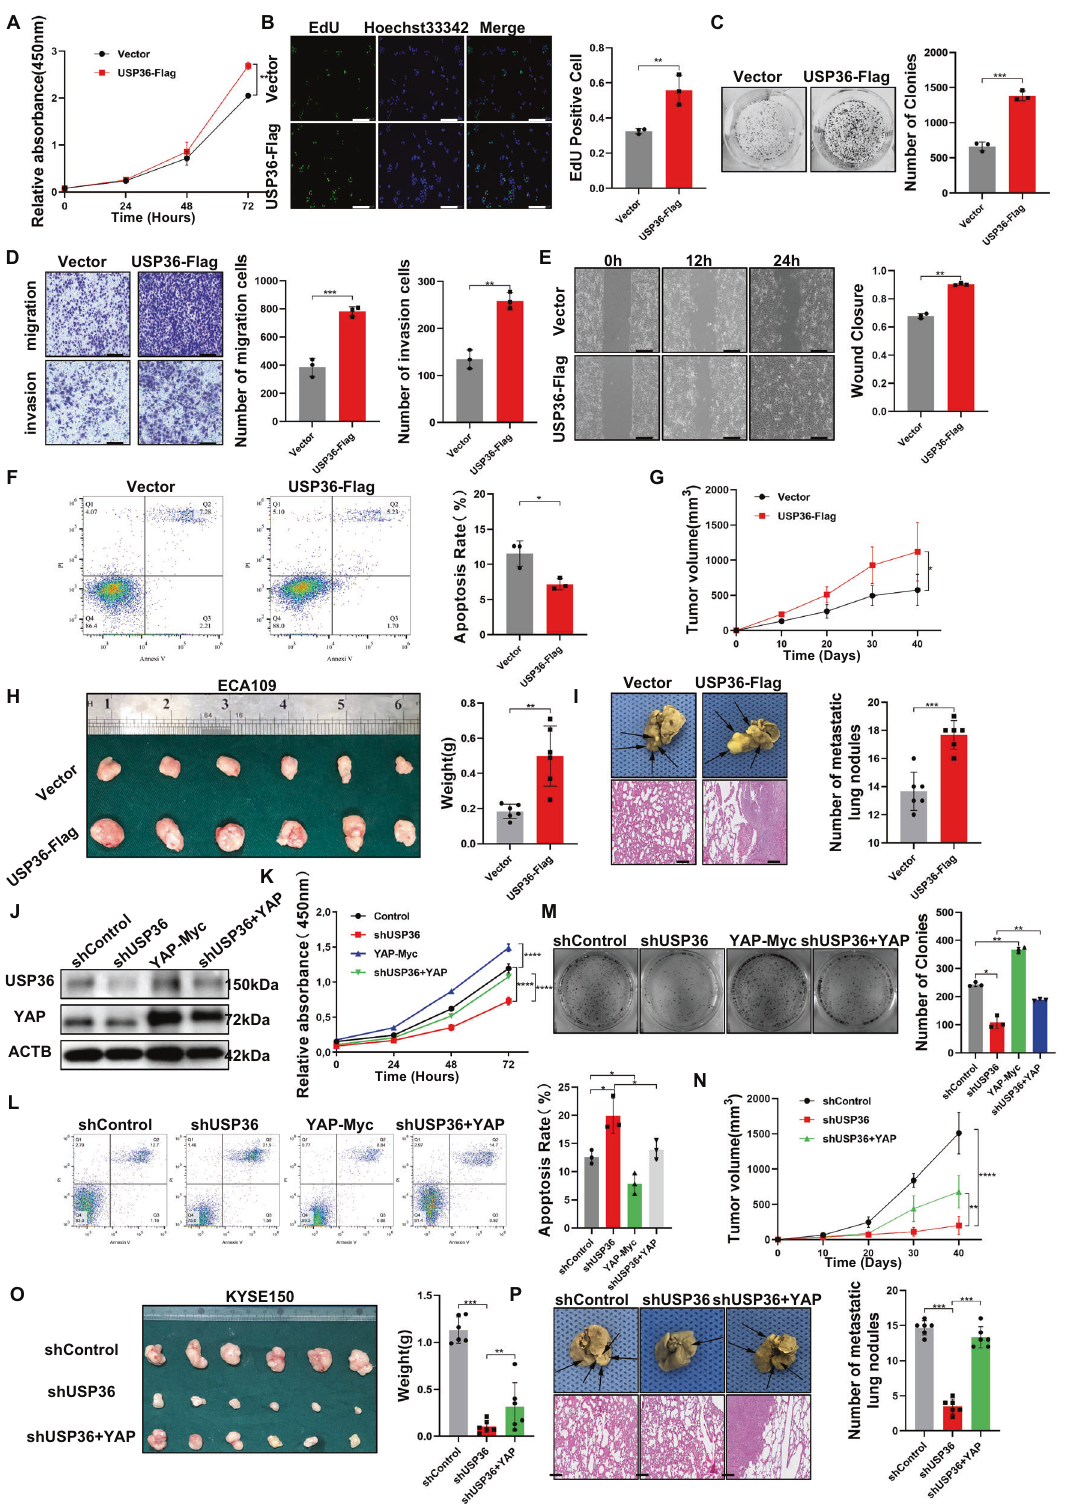
critical for USP36 to exert its deubiquitinase function [29], we made a mutation variant and transfected it into HEK293 cells. The western blotting data indicated that the C131 site of USP36 was required for its regulation of YAP protein expression (Fig. 5I). The qPCR data indicated that the C131A mutant form abolished the effect of USP36 on Hippo target gene expression (Fig.